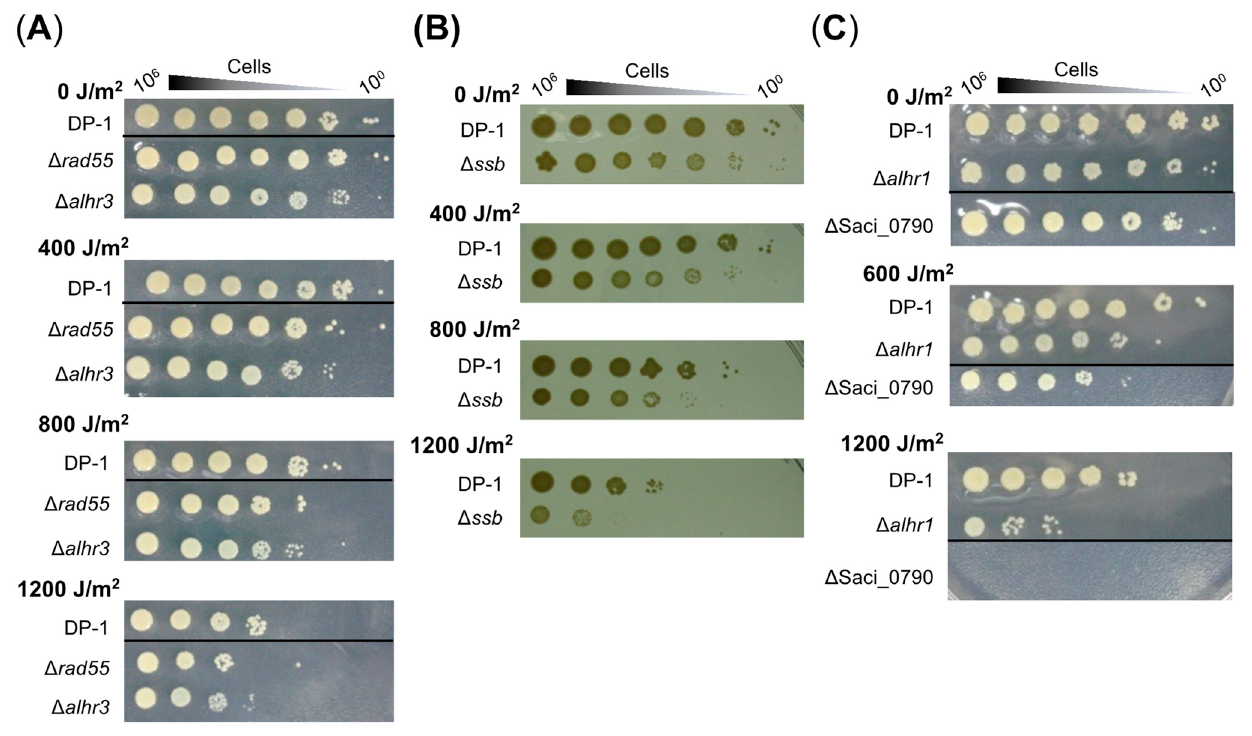
Figure 3. UV survival in the knockout strains. Each overnight culture of DP-1 (parent strain), ∆ rad55 , ∆ alhr3 , ∆ ssb , ∆ alhr1 , and ∆ Saci_0790 was exposed to UV-B light (0, 400, 600, 800, and 1200 J/m 2 ), and aliquots were serially diluted (10 0 –10 − 6 corresponding to 10 6 –10 0 cells) and spotted onto plates. Plates were incubated at 75 °C. UV survival for Δ rad55 and Δ alhr3 , Δ ssb , and Δ alhr1 and Δ Saci_0790 is shown in ( A – C ), respectively. Experiments were repeated three times with similar results.